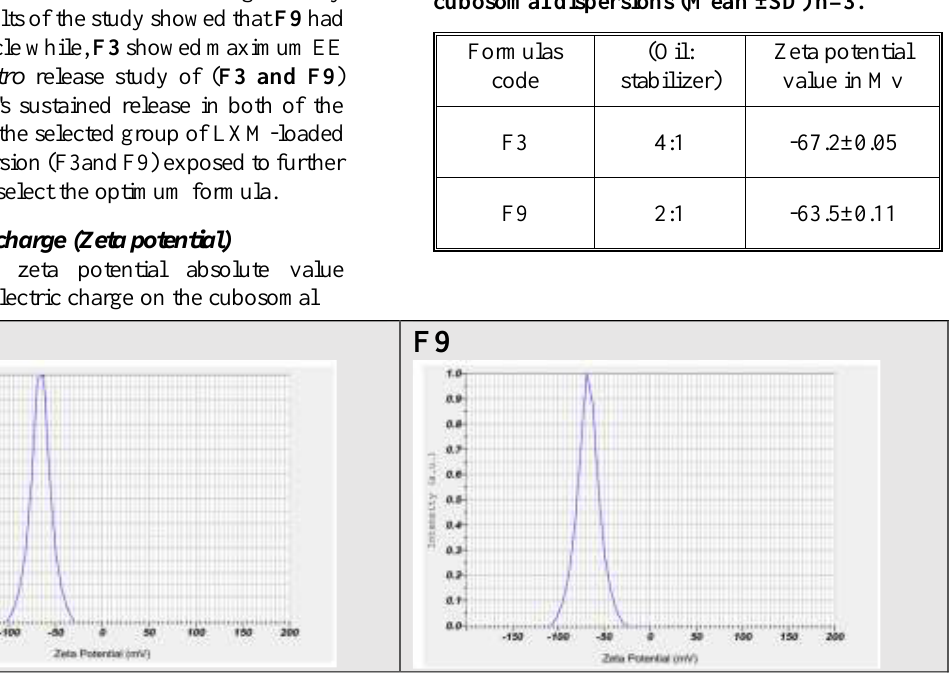
Figure 2. Zeta potential values of LXM-loaded cubosomal dispersions. Transmission Electron Microscopy The external morphology images of the selected group of LXM-loaded cubosomal dispersion (F3 and F9) were taken using transmission electron microscopy (TEM).